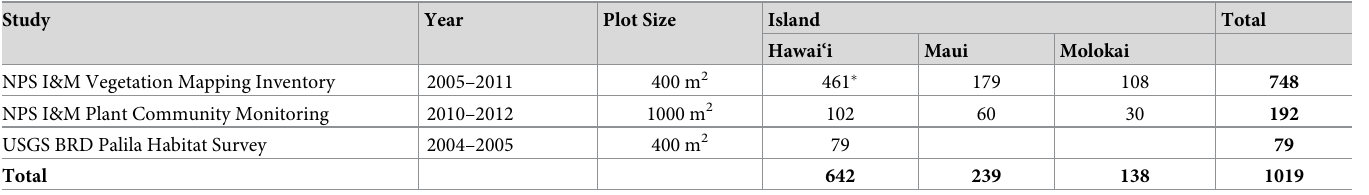
Table 2. Three data sets used to rank plant species’ habitat specialization. Data were collected between 2004 and 2012 with plot size ranging from 400–1000 m 2 .